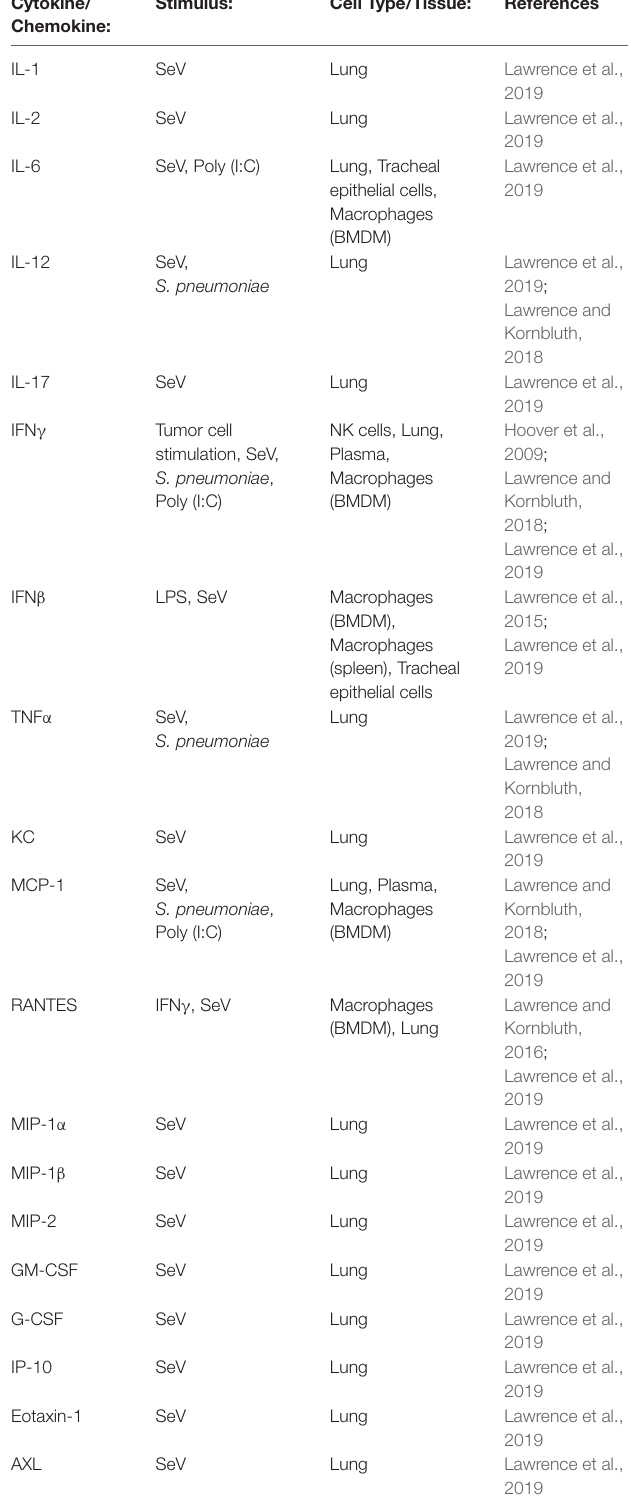
TABLE 1 | Proinflammatory cytokines and chemokines were measured in NKLAM − / − and WT cells treated with LPS or IFN γ in vitro and in biological tissues and organs from NKLAM − / − and WT mice exposed to live pathogens or TLR agonists in vivo